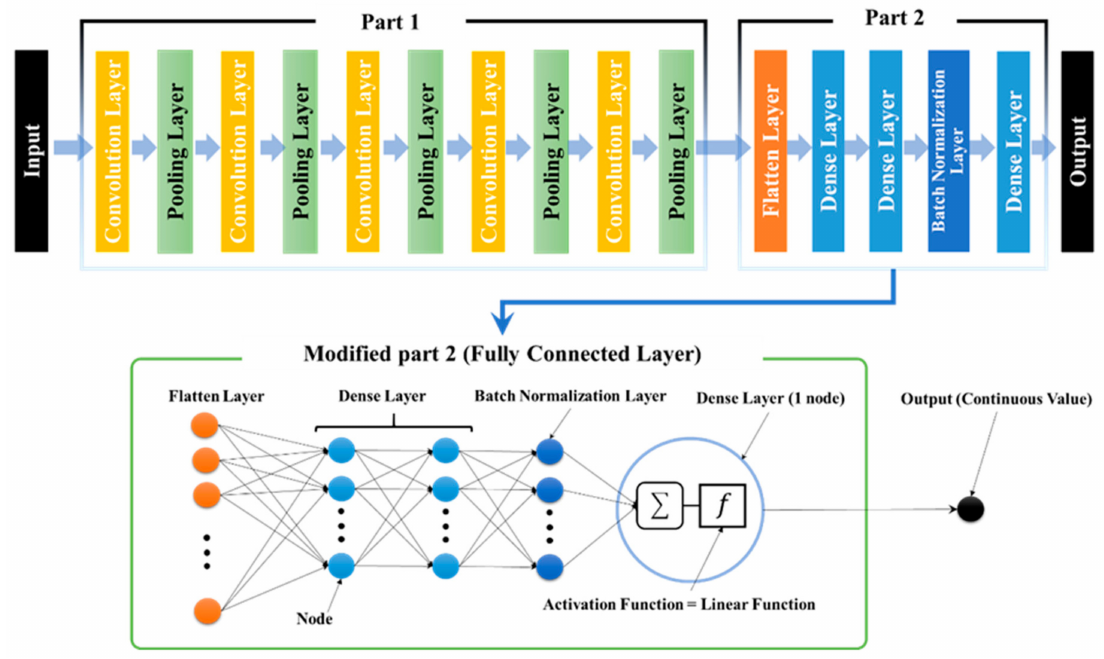
Figure 4. Structure and modified part 2 of the convolutional neural network (CNN) model for continuous variable